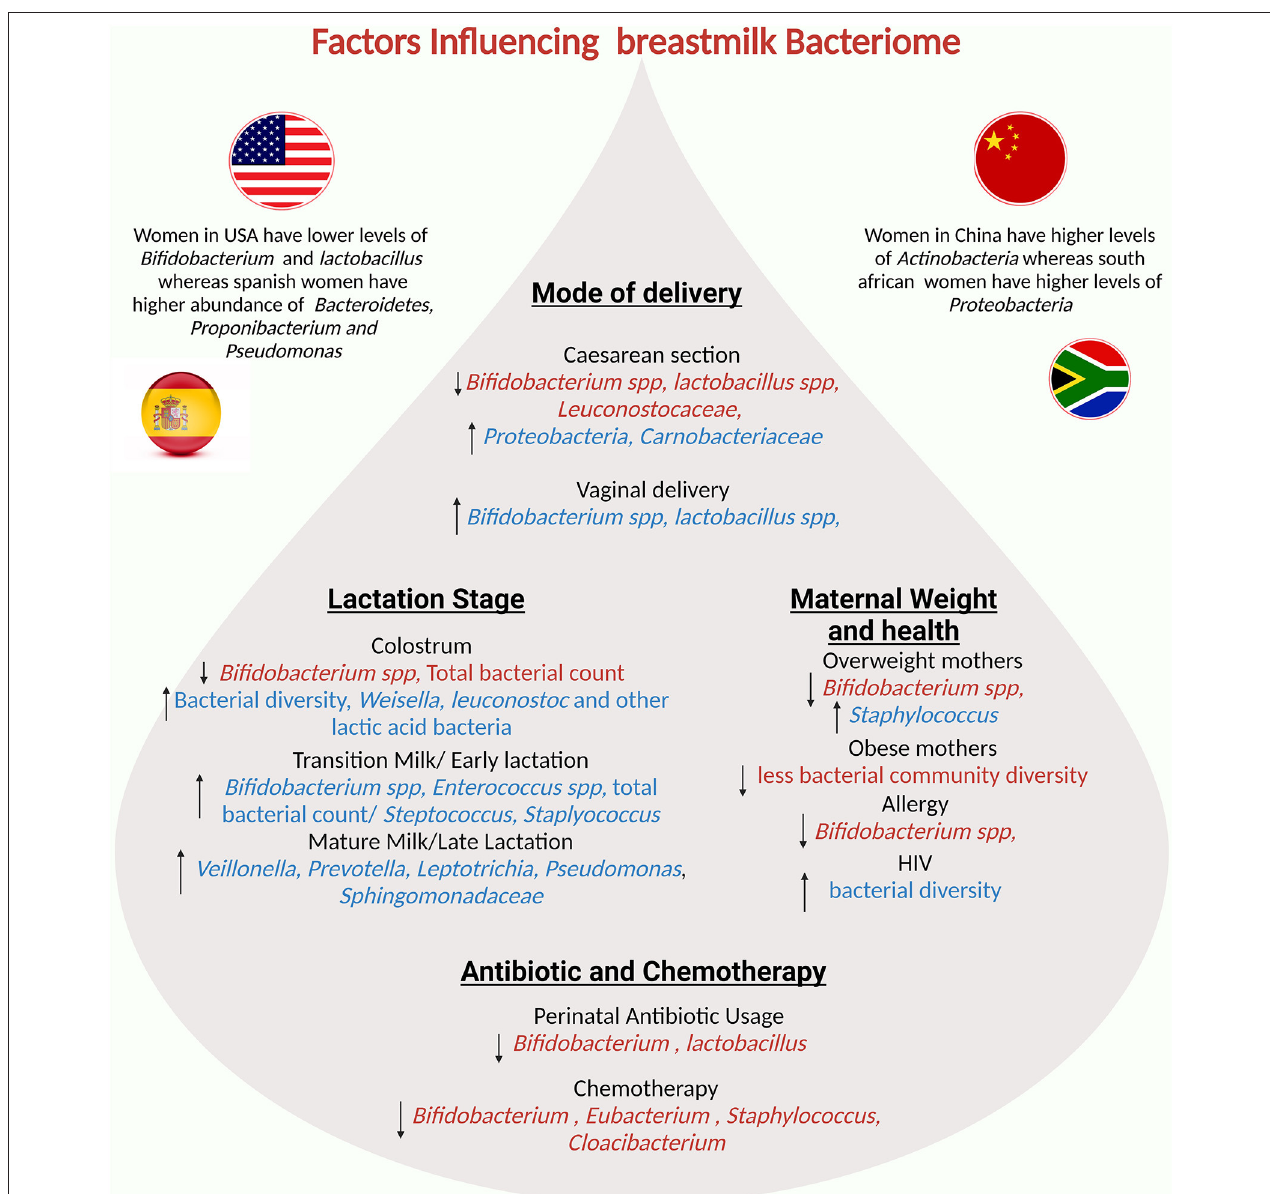
FIGURE 4 | Potential factors influencing the breastmilk bacteriome: mode of delivery, maternal factors, lactation stage, and geographical region influence human milk